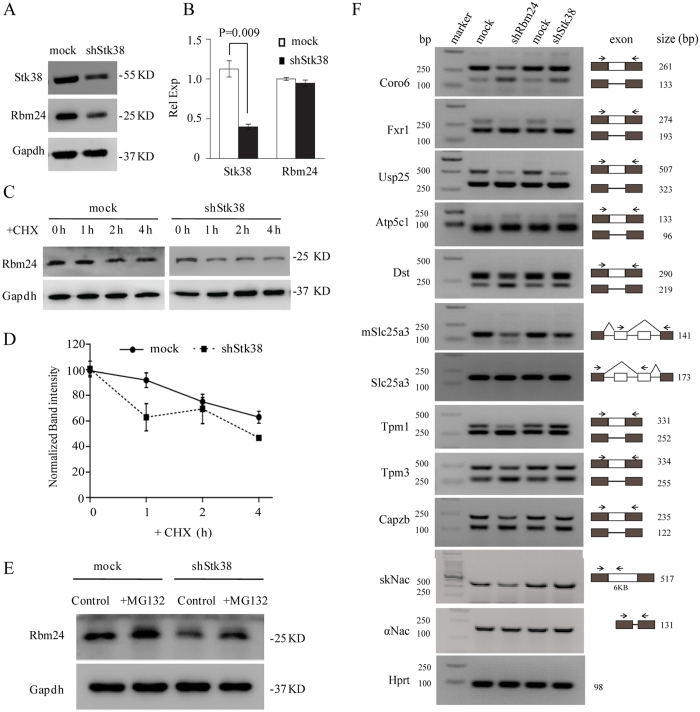
Stk38 affects Rbm24 protein stability and splicing activity.(A) HL-1 transfected with control vector or shStk38. Western blot was done using antibodies against Stk38, Rbm24, and Gapdh. Result shows that transfection with shStk38 was able to knockdown the protein level of Stk38, which in turn reduced the level of Rbm24 protein. (B) qRT-PCR analysis showed knockdown of Stk38 in HL-1 cells did not affect mRNA level of Rbm24, indicating that Stk38 did not regulate Rbm24 at the mRNA level. P-values were calculated using Student’s t-test with significance set at p < 0.05. Values where p < 0.05 are shown (n = 3). (C) HL-1 cells were transfected with shStk38 before the half-life of Rbm24 protein was analyzed by immunoblotting of total protein lysates harvested at the indicated times after inhibition of protein synthesis by CHX. (D) Densitometric analysis of Rbm24 level normalized with Gapdh protein level at each treatment time point with CHX as compared with the initial level of Rbm24. Result shows that reduction of Stk38 greatly reduced the level of Rbm24 overtime with CHX treatment, further justifying that Stk38 could be required for Rbm24 stability (n = 3). (E) HL-1 or HL-1-shStk38 cells were treated with MG132. Total cell lysates were subjected to western blot analysis with anti-Rbm24 and anti-Gapdh antibodies. Results show that Stk38 increases the stability of Rbm24 by preventing its degradation via ubiquitin-proteasome protein degradation pathway. (F) Splicing analysis for the indicated RNAs was performed by RT-PCR with HL-1-shRbm24 and HL-1-shStk38 cells. Primers and expected band sizes are indicated. Naca has two isoforms, skNAC and aNAC, generated by alternative splicing of exon 2. skNAC, which contains exon 2, is specifically expressed in muscle tissues, whereas aNAC is expressed ubiquitously. mSlc25a3 represents the muscle-specific isoform of Slc25a3. Hprt was used as an internal control. The images of (A,C,E,F) shown are cropped. The full-length blots or original images are shown in Figure S3.